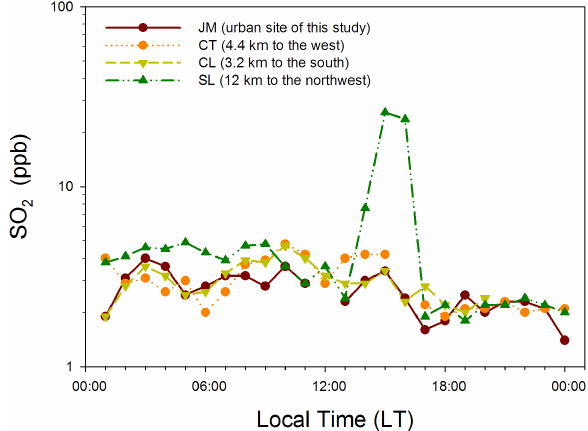
Fig. A2. Diurnal variations of SO 2 measured at the urban site (JM) and three nearby air quality monitoring sites (CT, CL and SL) on the 12 August